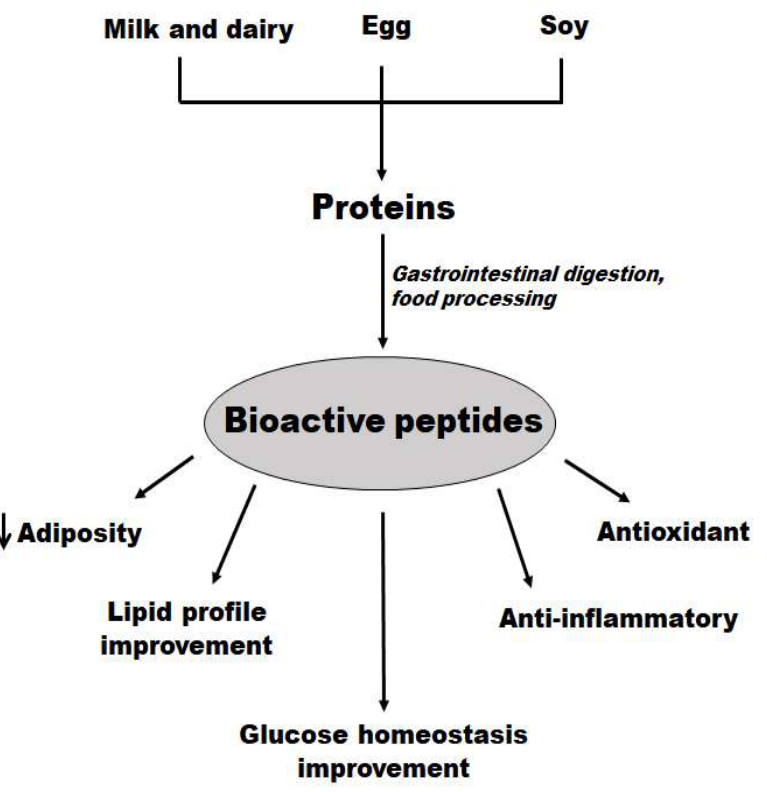
Figure 2. Summary of the main effects of bioactive peptides from food on obesity and related metabolic disturbances.